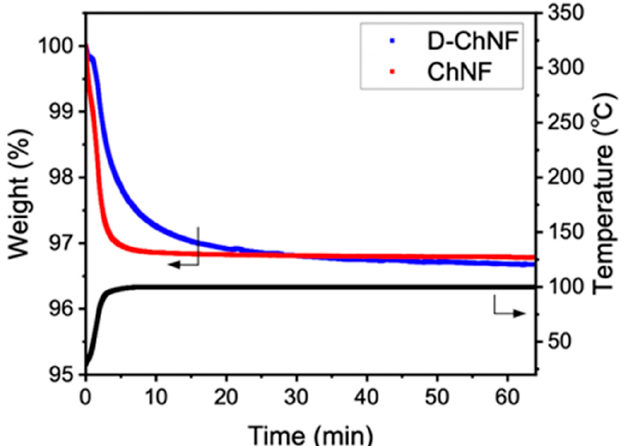
Figure 5. Typical profiles of thermogravimetric analysis of the ChNF and D-ChNF films just after conditioning at relative humidity below 10%.